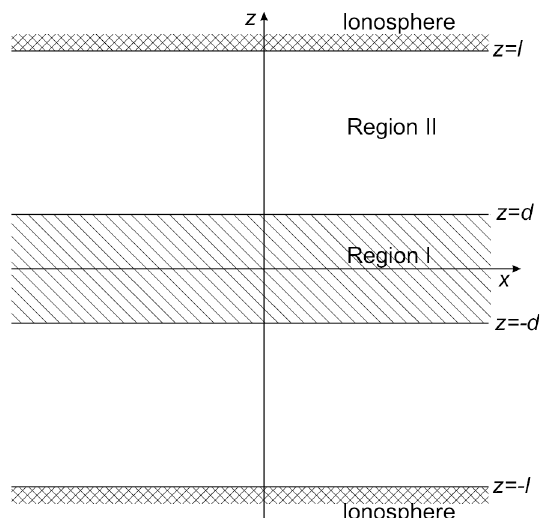
Fig. 5. A model field-aligned distribution of the background plasma. The magnetic field lines are straight and directed along the z axis, the hatched region corresponds to the dense plasma disk (region I), there are regions of rarefied plasma between the disk and ionosphere (regions II). The external forces act along the x axis, and in the case of the small-scale perturbations, Cartesian coordinates can be used, where the y axis corresponds to the azimuth